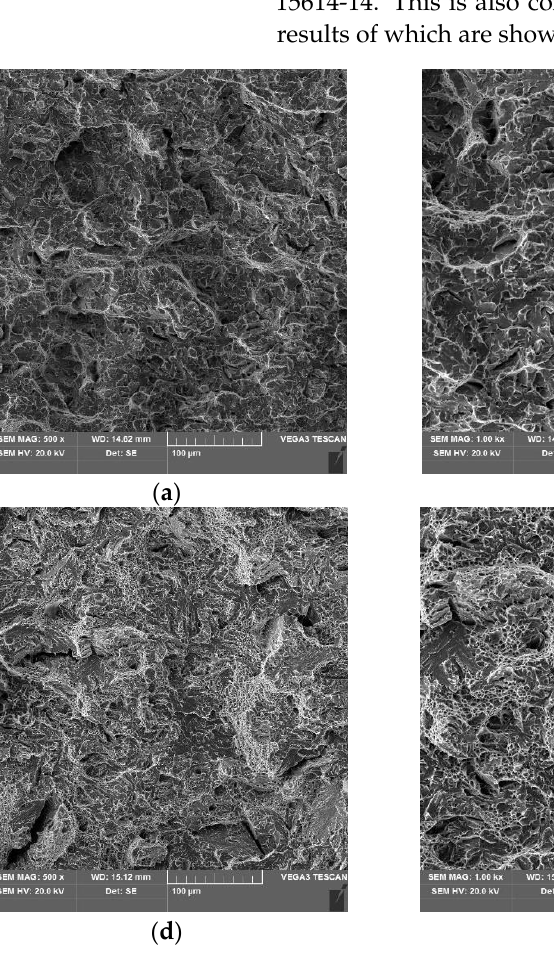
Figure 11. SEM image of the fracture surface of the specimens after impact testing; ( a – c ) VWT specimens, ( d – f ) VHT specimens.